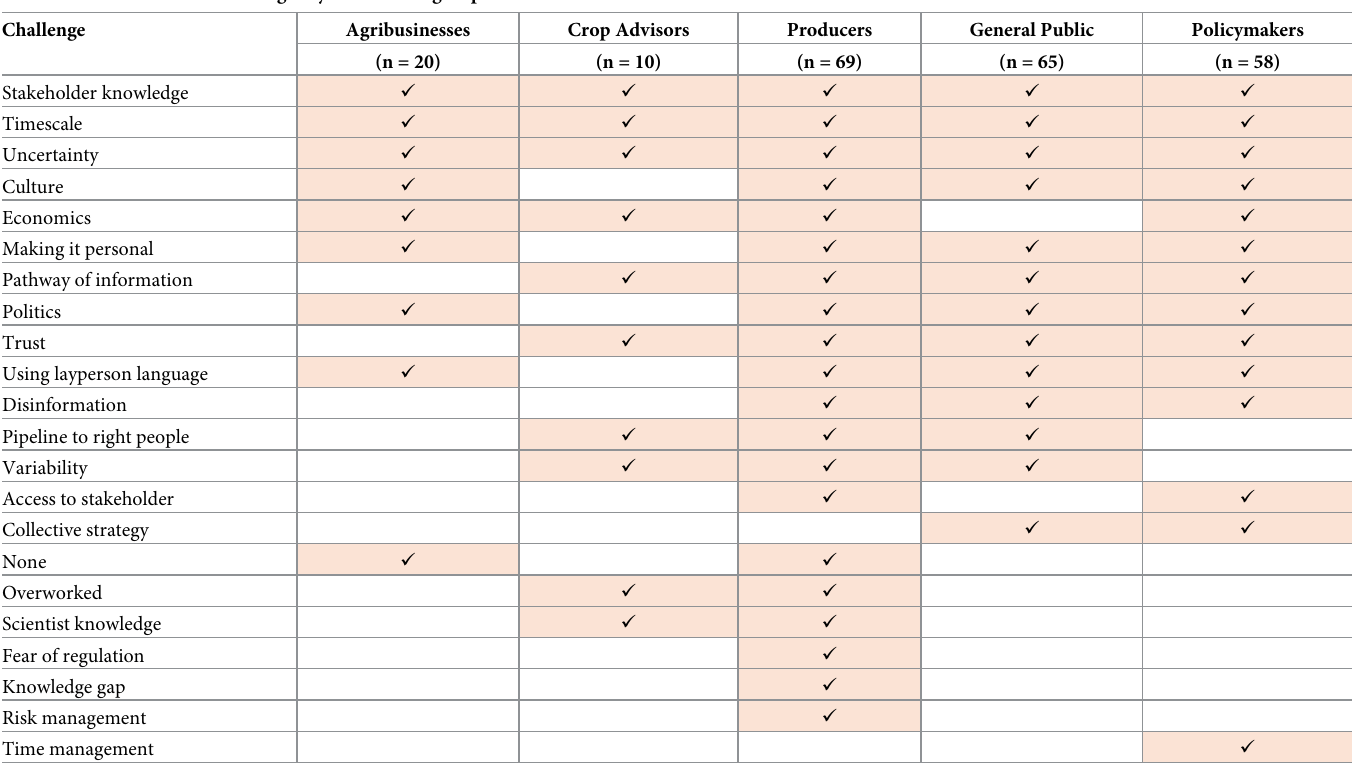
Table 2. Communication challenges by stakeholder